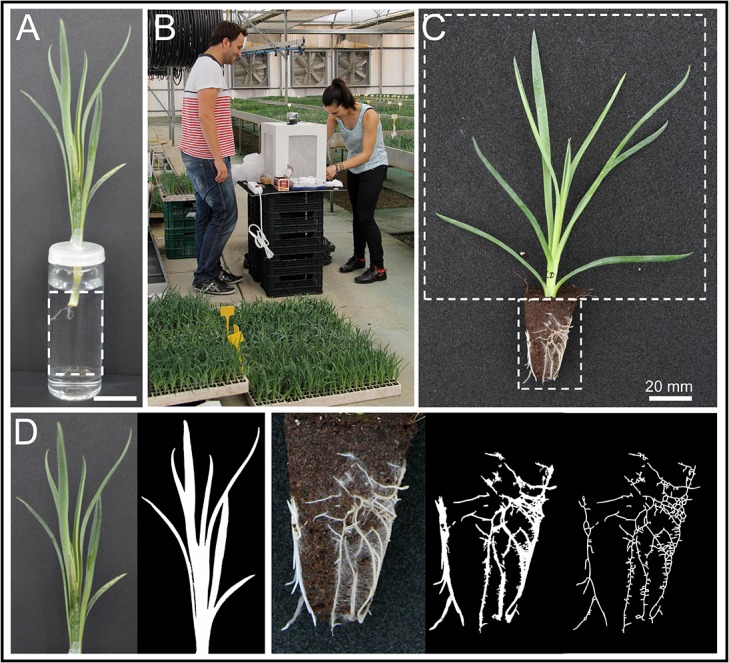
Morphological characterization of carnation stem cutting phenotypes.(A) A representative image of a stem cutting grown in vitro for 17 days. (B) Portable photographic bench used for image acquisition of stem cuttings grown in soil plugs at the rooting station. (C) A representative image of a stem cutting grown in soil plugs for 27 days. Dotted lines indicate the area of the image used for the morphometric analysis. (D) Image segmentation files obtained with the Gia Roots software, as described in Materials and Methods.